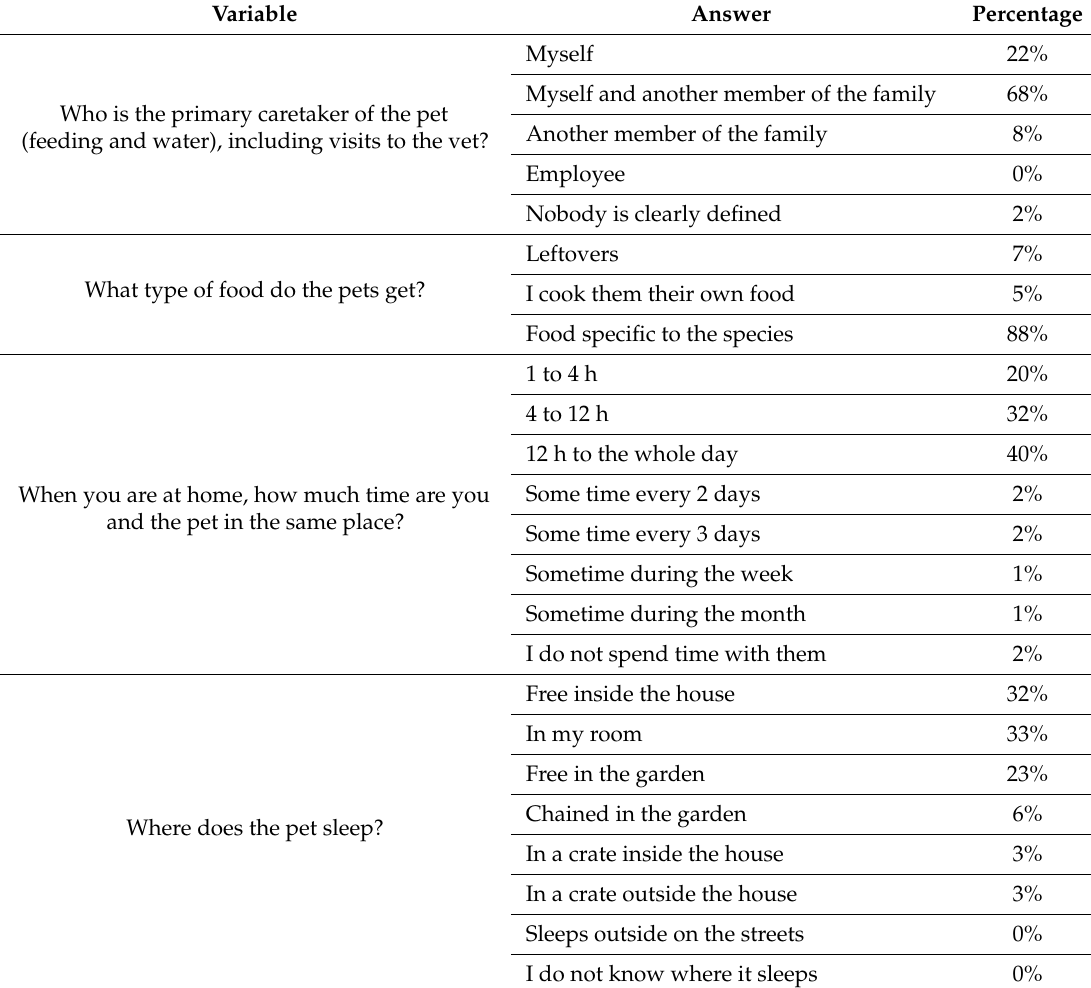
Table 3. Companion animal